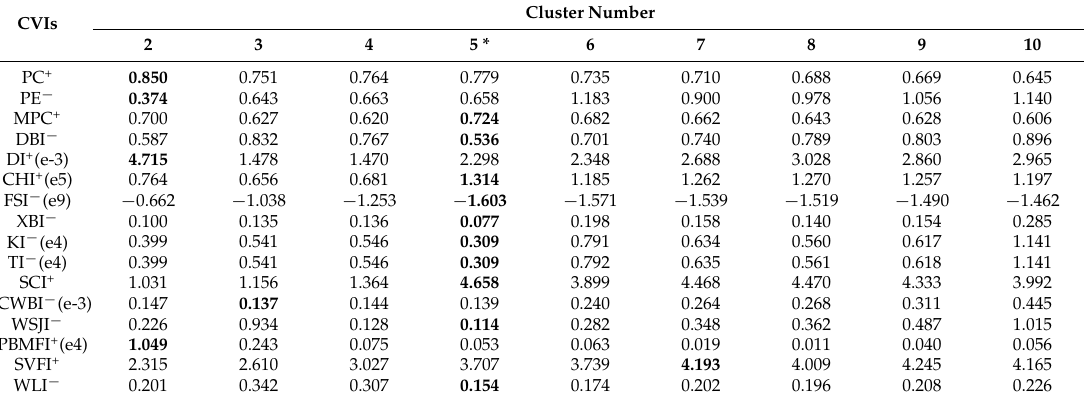
Table 6. Variations of the 16 CVIs with cluster numbers ranging from 2 to 10 for the GaoFen-1 image.